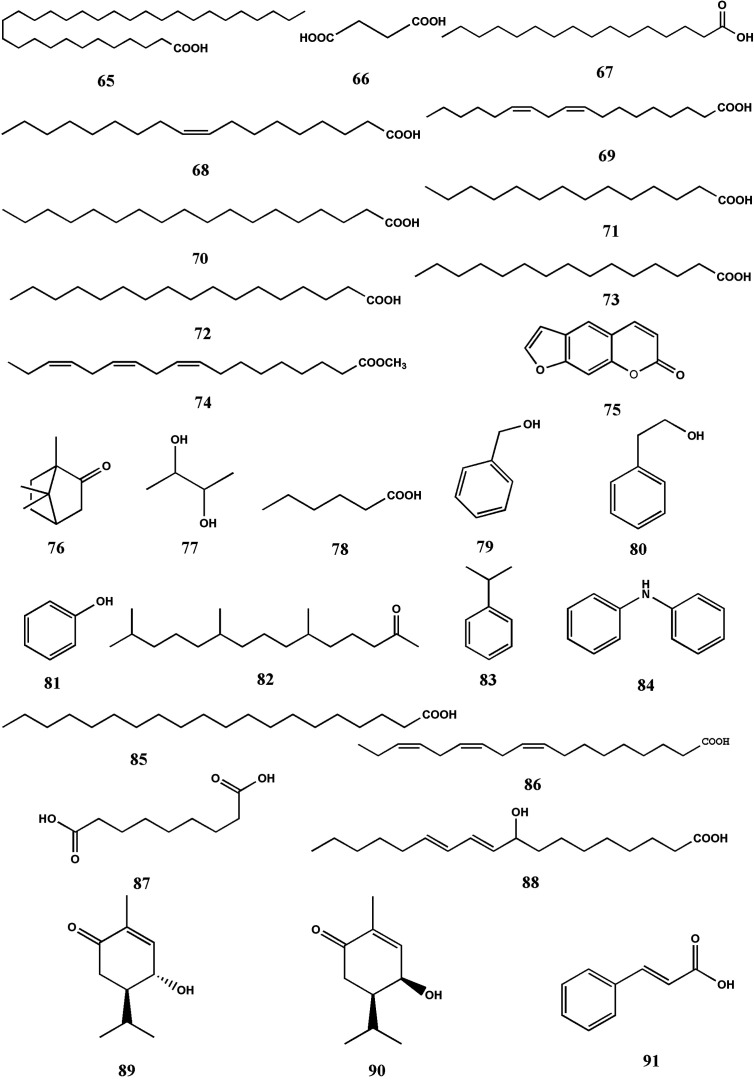
Structures of volatile oil and fatty acids from Tetrastigma hemsleyanum Diels & Gilg.